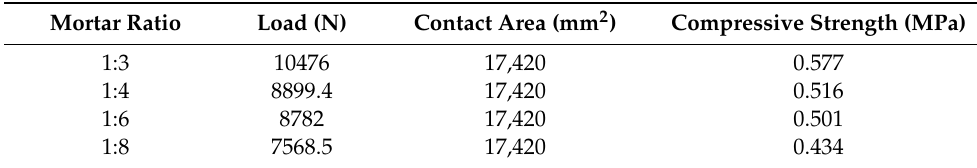
Table 3. Prism brick masonry bond